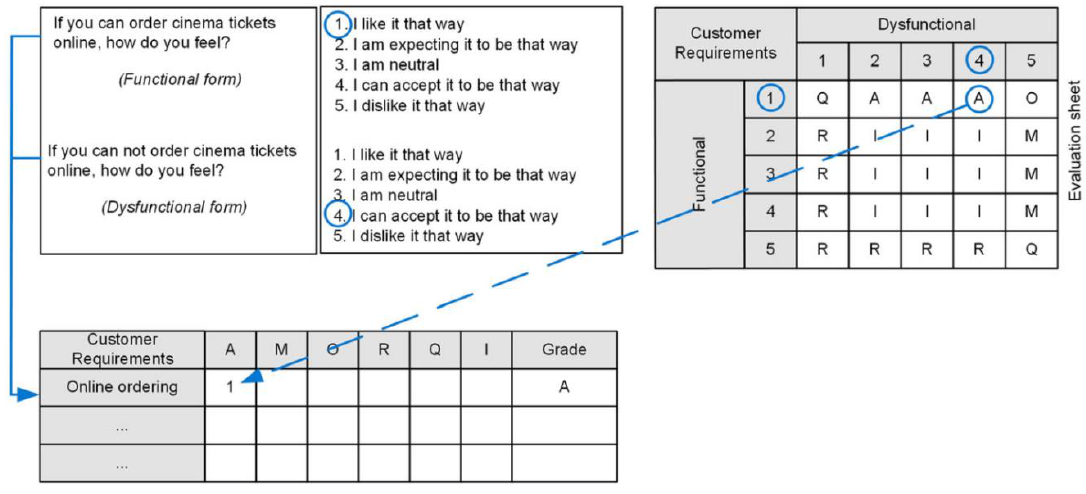
Figure 1. Categorization of a requirement using Kano approach (Witell and Löfgren 2007).